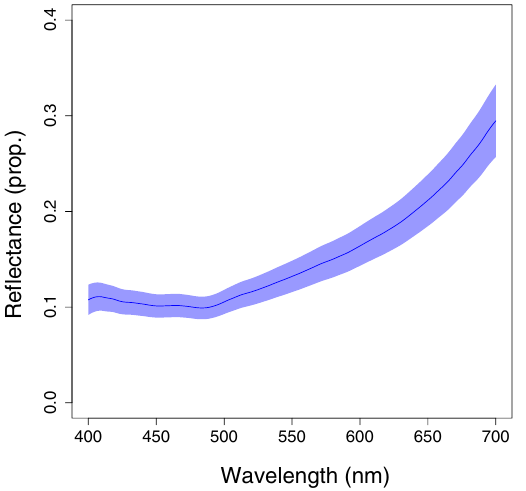
Figure 5. Iris reflectance. Reflectance values are expressed as proportions of the iris photon radiance normalized by the radiance of the associated PTFE white standard. Shaded area represents the standard error of the